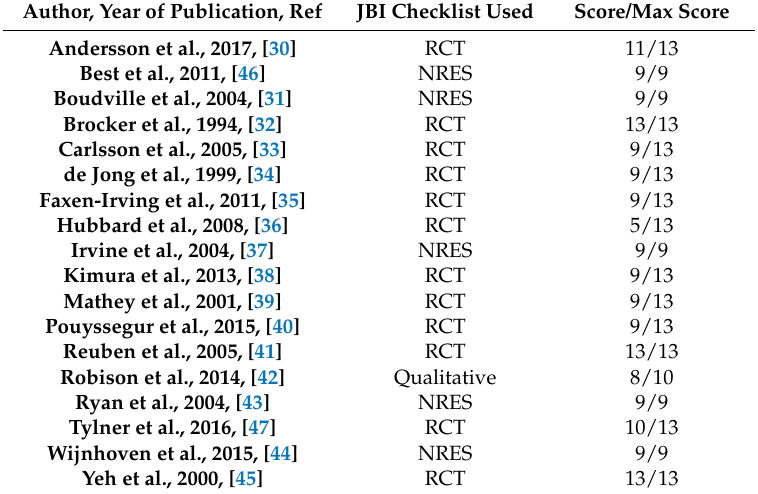
Table A1. Quality assessment using Joanna Briggs Institute checklist for study